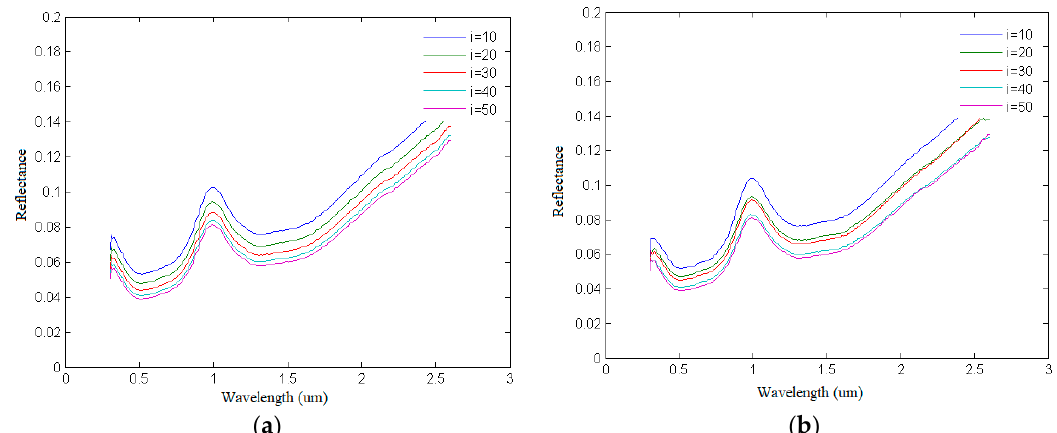
Figure 19. Comparison of the simulated spectra ( a ) and measured spectra ( b ) of ilmenite when the Legendre polynomial coefficients of the phase function are set to − 0.6775 and 0.5475.